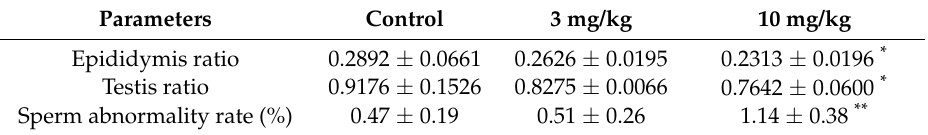
Table 3. Summary of necropsy (Mean ±